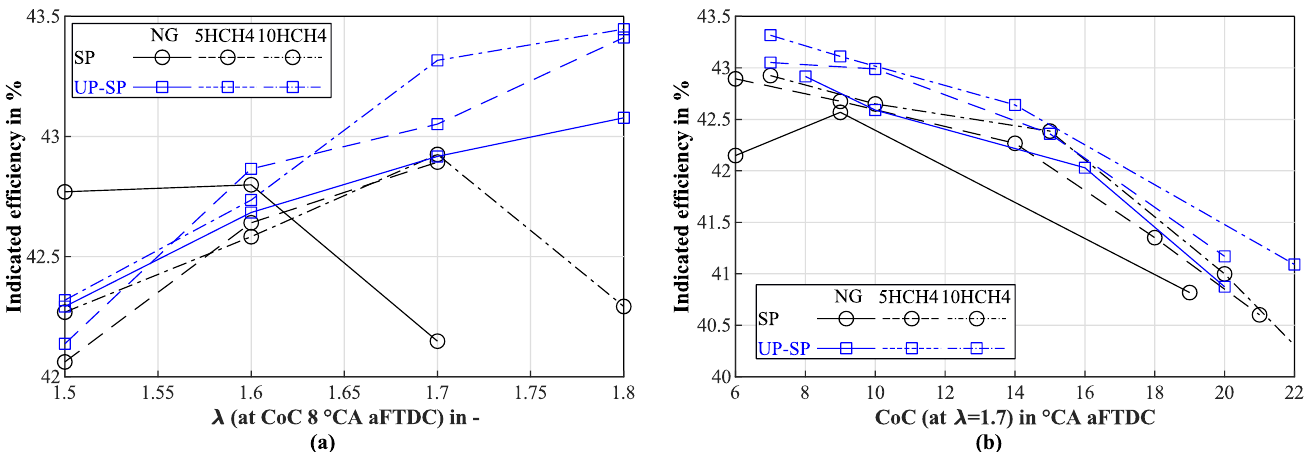
Figure 6. ( a ) Indicated efficiency at constant air–fuel equivalence ratio of 1.7; ( b ) Indicated efficiency at constant CoC of 8 °CA aFTDC.